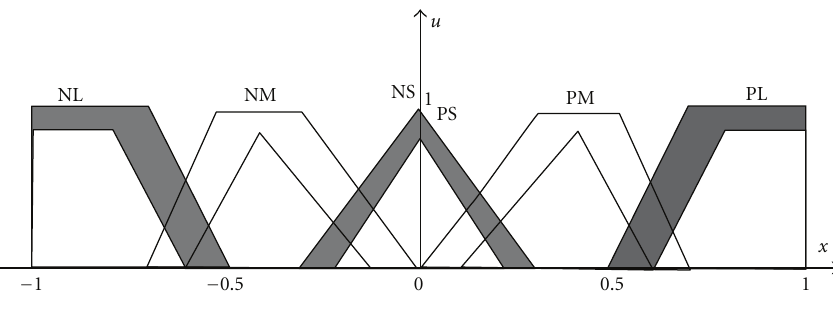
Figure 11: Membership grades of